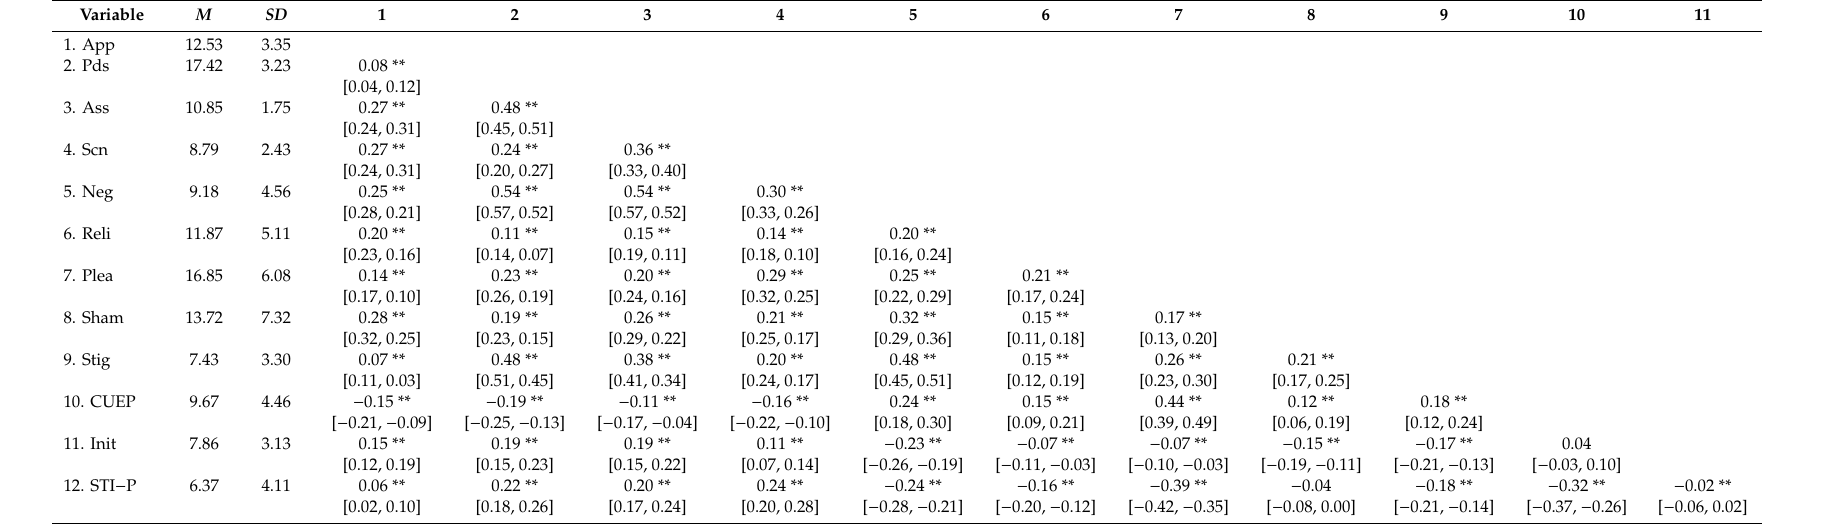
Table 6. Means, standard deviations, and correlations with confidence